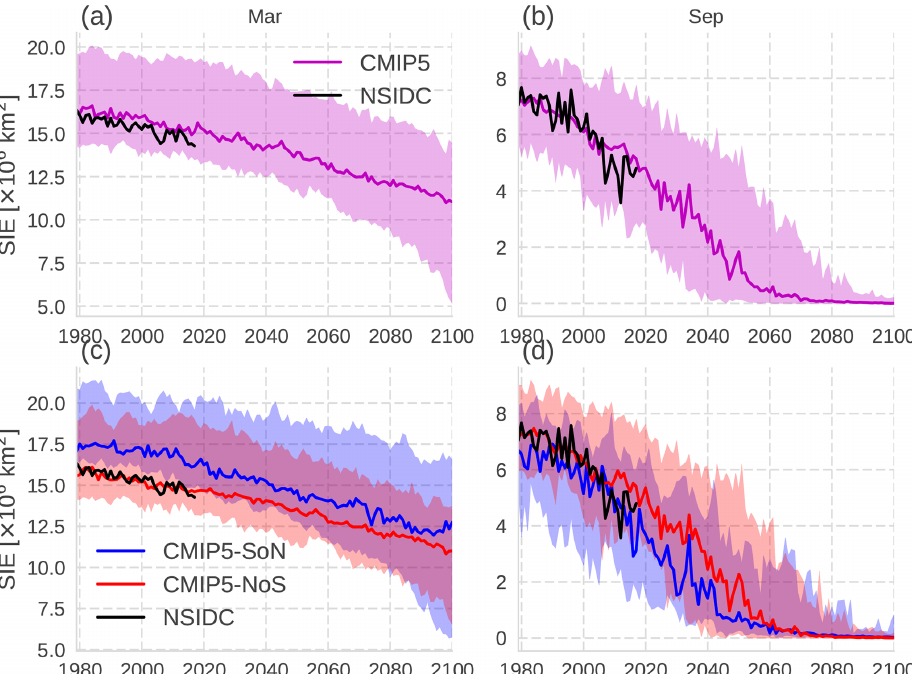
Figure 1. Arctic sea ice extent in NSIDC observations (black) and CMIP5 climate models (line is ensemble median, shading is 10%–90% range). (a) Full ensemble in March, (b) full ensemble in September, (c) CMIP5 split into sub-ensembles of models with FIRE (CMIP5-SoN) and those without (CMIP5-NoS) in March, and (d) SoN and NoS in September.